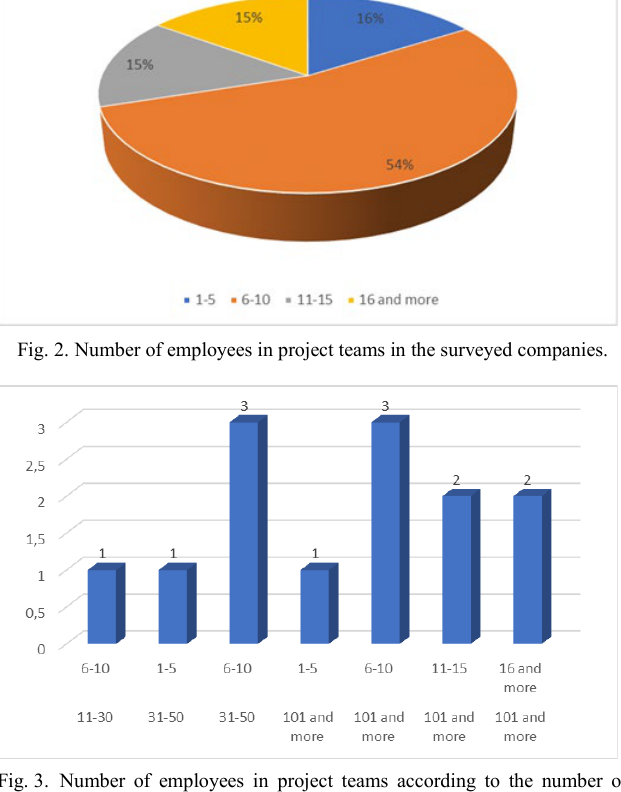
Fig. 3. Number of employees in project teams according to the number of employees in the surveyed